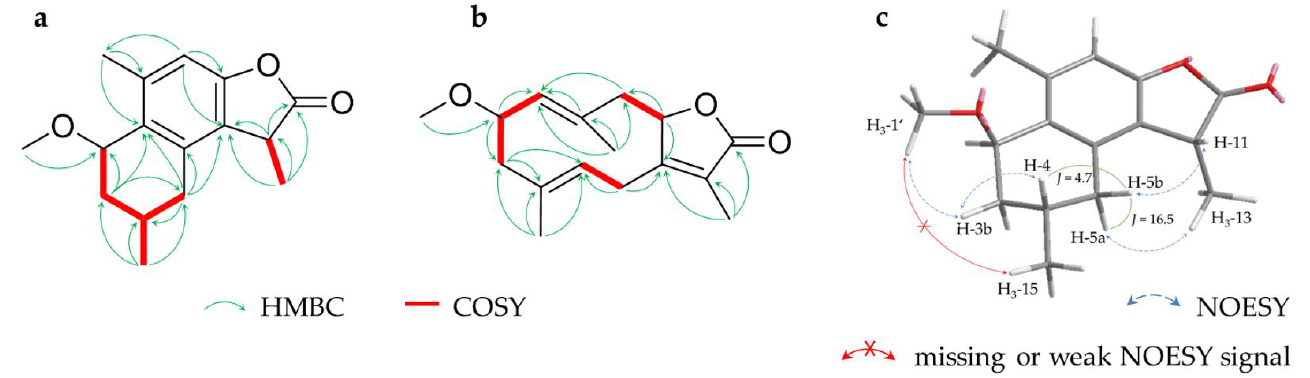
Figure 3. Key HMBC and COSY correlations for compounds 4 ( a ), the diastereomers 5 and 6 ( b ) as well as relevant (or missing) NOESY signals for compound 4 ( c ); J in Hz.